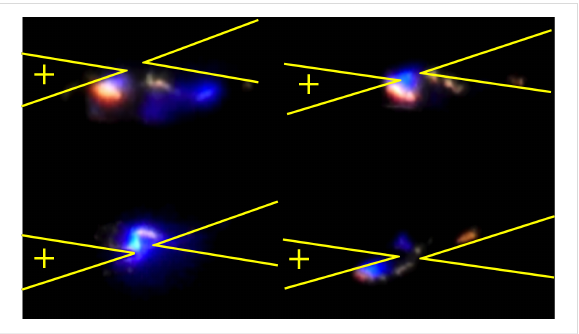
Figure 3: Frames extracted from high-speed videos showing light emission and changing percolation paths during DC tests with an ap- proximate probe distance of 10–15 μ m. The probe locations and applied voltage polarity are as indicated in yellow (multimedia